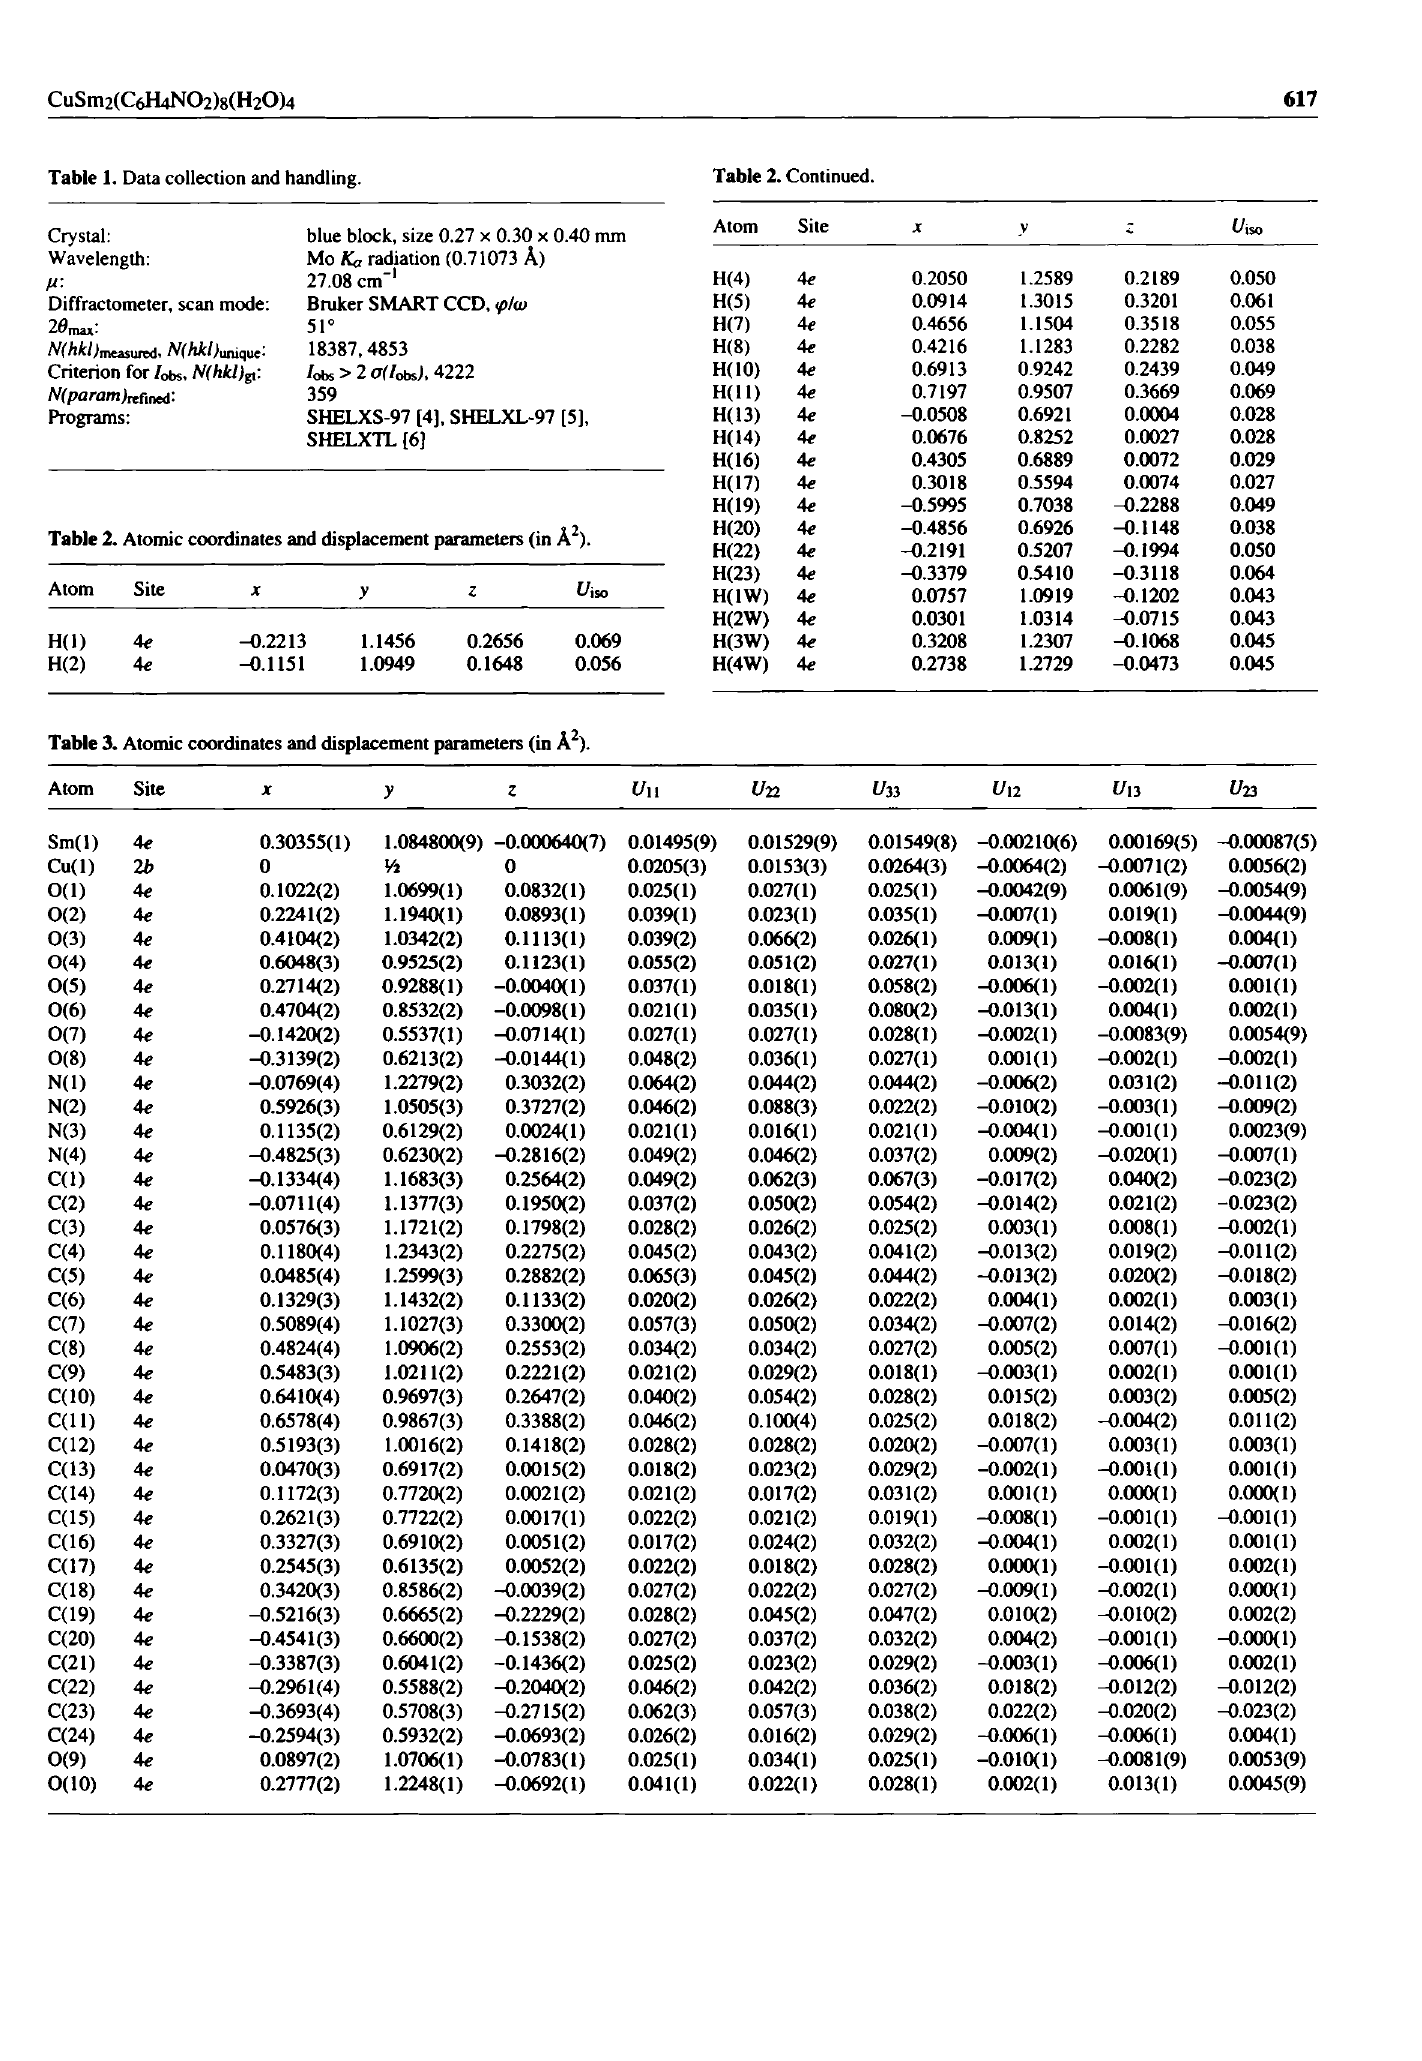
Table 1. Data collection and handling.